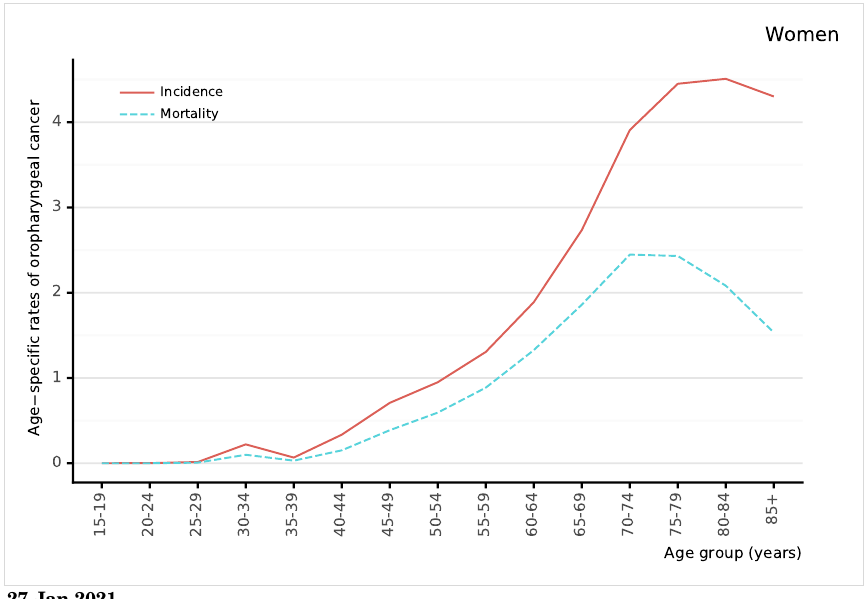
Figure 41: Comparison of age-specific oropharyngeal cancer incidence and mortality rates